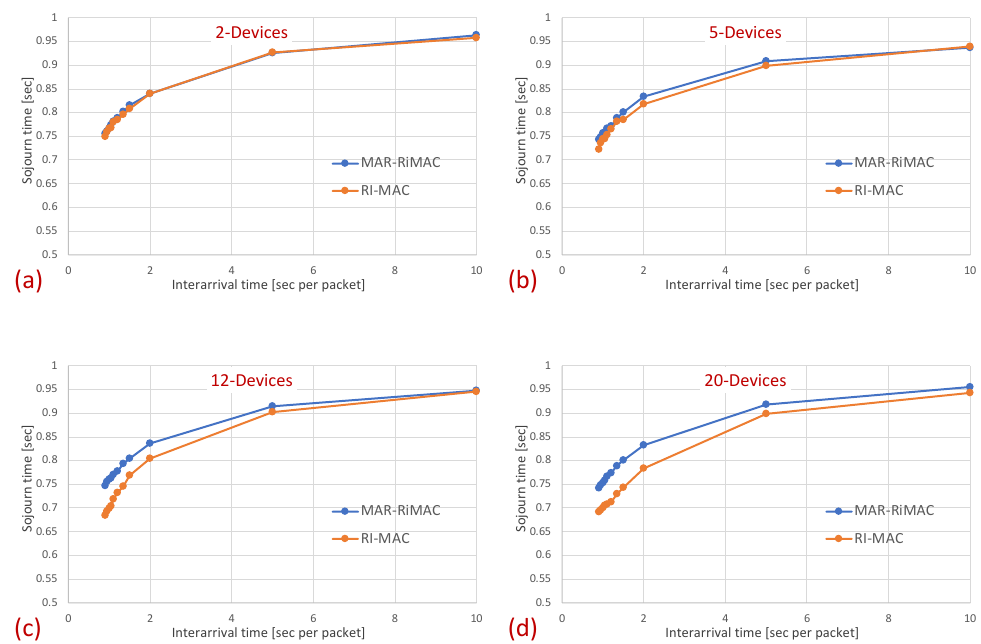
Figure 7. Clique topology: Mean sojourn time for different numbers of devices and maximal number of simultaneous transmissions supported by MAR-RiMAC; K = 4. ( a ) Two devices. ( b ) Five devices. ( c ) Twelve devices. ( d ) Twenty